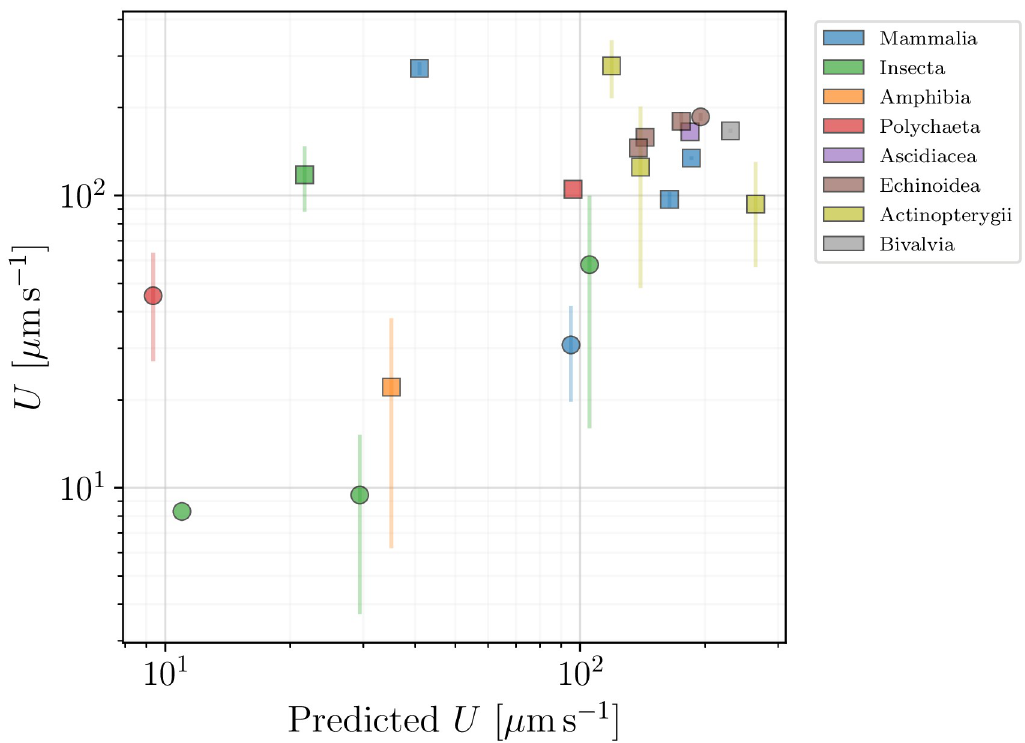
Fig 18. Reported propulsion speed of spermatozoa compared with the values predicted by the theoretical model in Eq (30). Colour scheme distinguishes between the different taxonomic classes. Squares represent spermatozoa that had all parameters available in the literature, while the circles mark cases where at least one parameter had to be estimated (via h W / B i = 0.47 from Fig 15 or through Eq (21)).